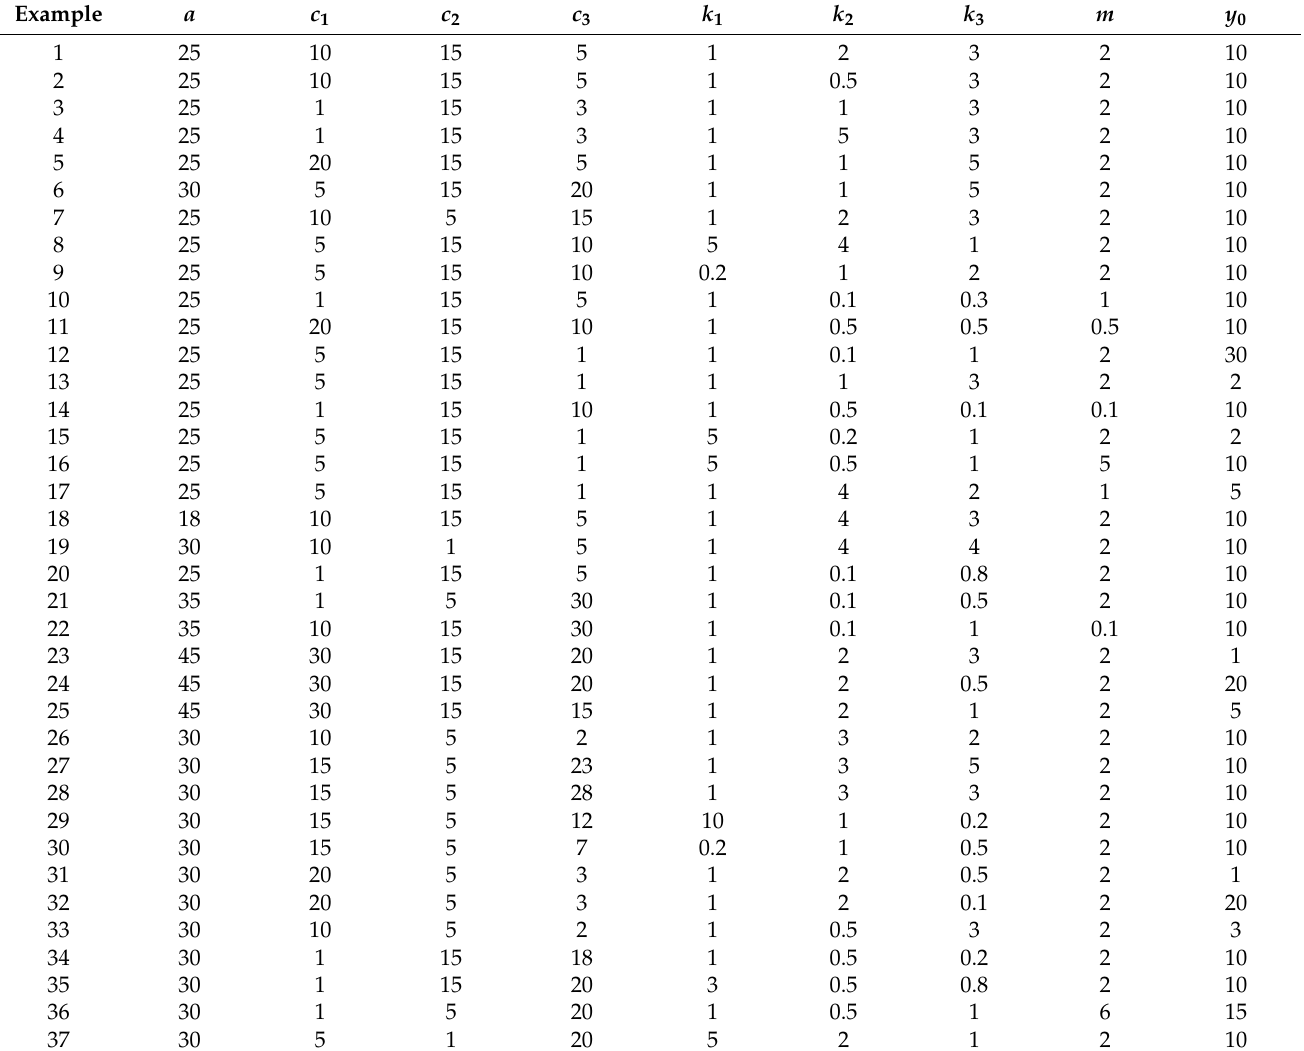
Table 3. Input data in the case of arbitrary agents ( n = 3